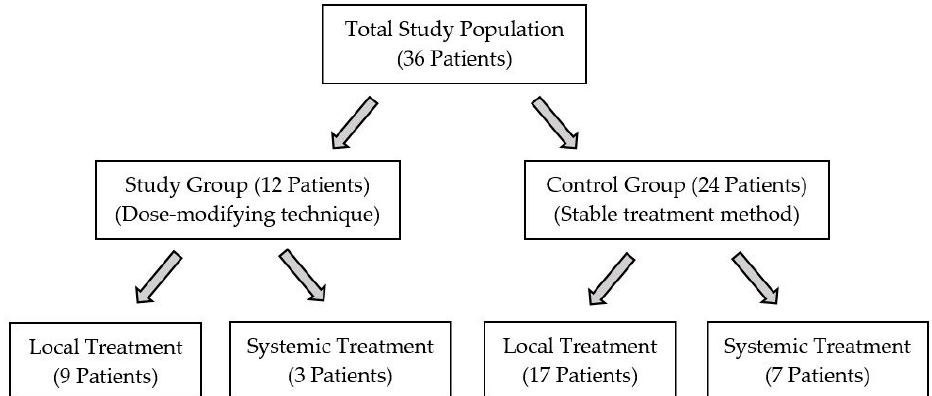
Figure 1. Grouping of participants and treatment methods